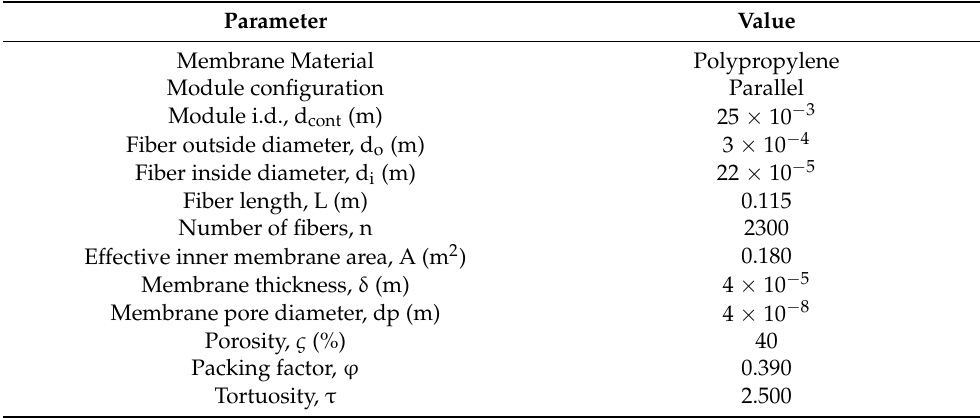
Figure 1. Commercial polypropylene hollow fiber membrane contactor in parallel configuration (1 × 5.5 MiniModule TM ). Table 2. Hollow fiber membrane contactor (HFMC) characteristics (1 × 5.5 MiniModule